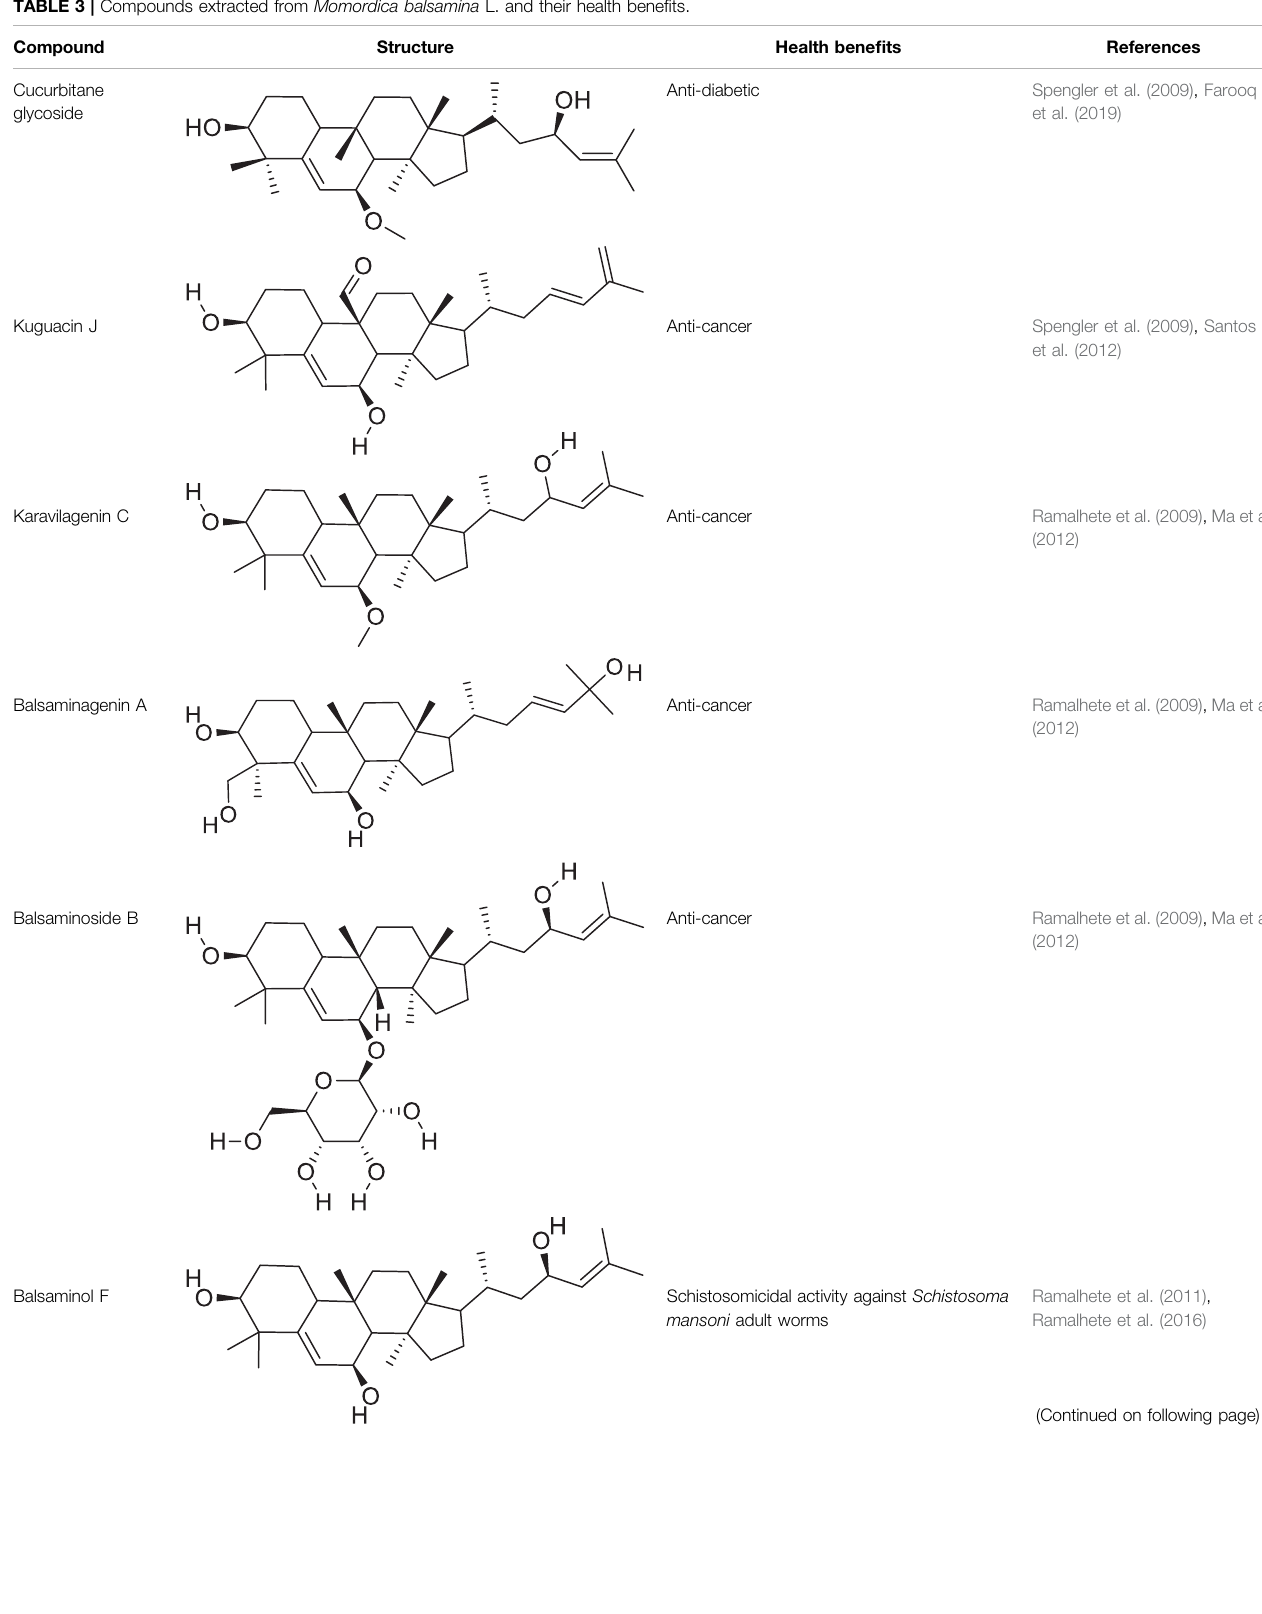
TABLE 3 | Compounds extracted from Momordica balsamina L. and their health bene fi